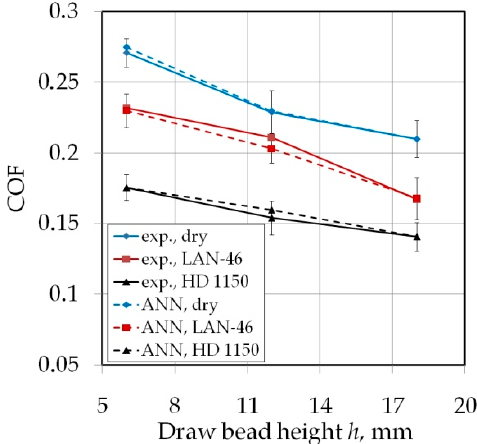
Figure 26. The effect of drawbead height on the value of COF (orientation 0, sample width w = 20 mm, average surface roughness of countersamples Ra = 1.25 μ m).